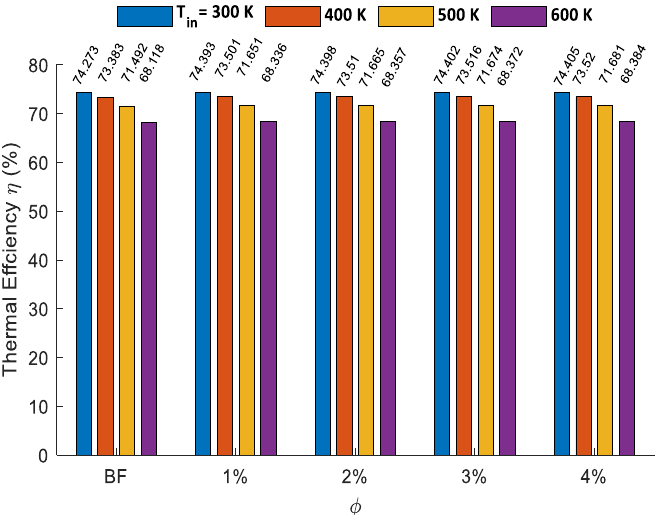
Figure 10. Thermal efficiency for base fluid and hybrid nanofluid under different temperatures and concentrations.